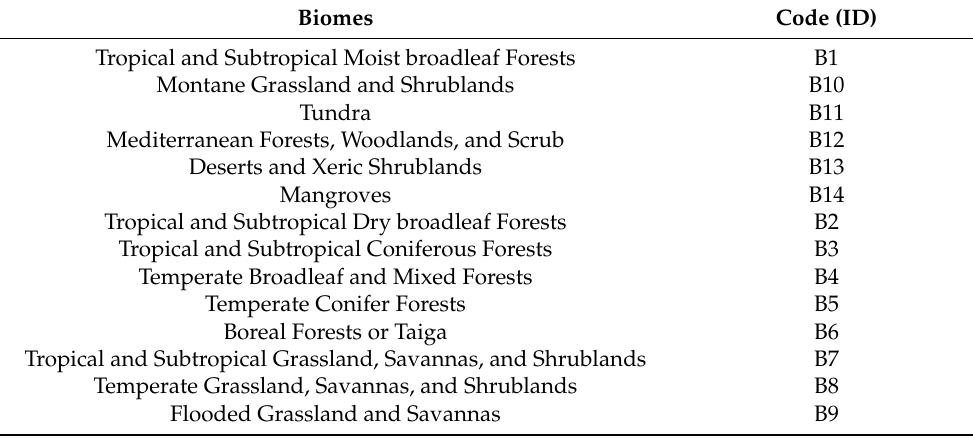
Table 1. Forest biomes present in the RESOLVE Ecoregions